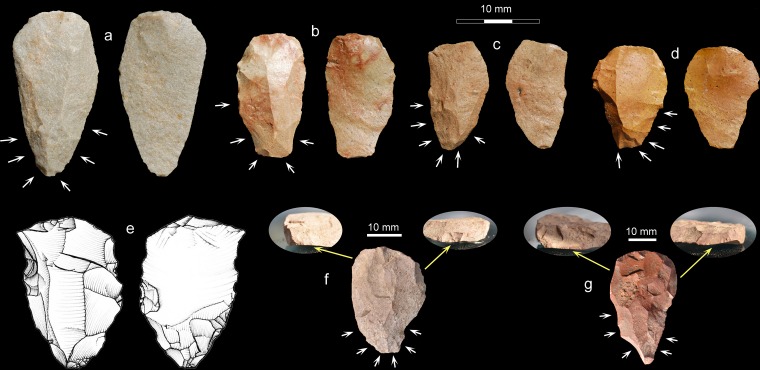
Levallois points with Nubian characteristic from UPK7 and Mertenhof.UPK7: a, quartzite; b-d, silcrete; Mertenhof: f & g, both silcrete. White arrows show directions of preparation removals. Overshot flake from Nubian-like core (e, silcrete). Inset images for Mertenhof points show damage immediately below flake platforms.